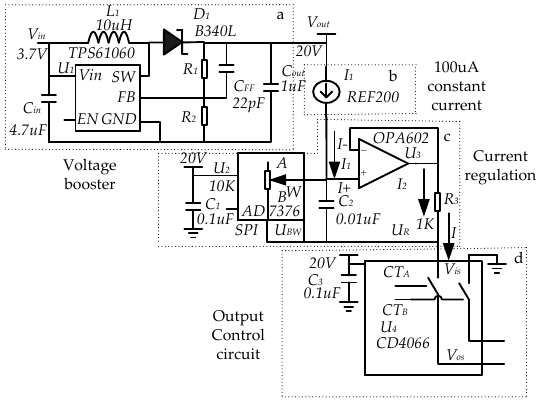
Figure 3. Circuit diagram of the reverse iontophoresis. ( a ) Voltage booster; ( b ) Constant current source; ( c ) Current regulation; ( d ) Output control circuit.